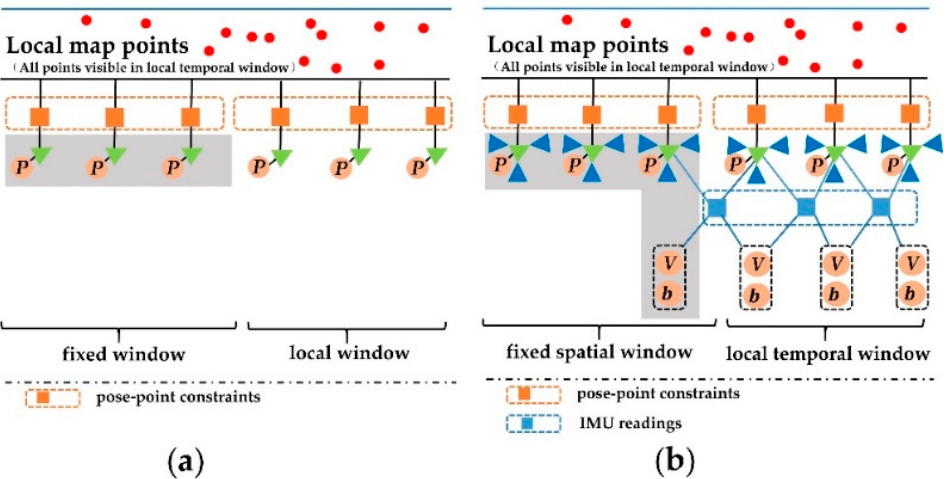
Figure 11. The comparison of the double window structure. ( a ) The double window structure of ORBSLAM; ( b ) the improved temporal-spatial double window structure of VINS-MKF.